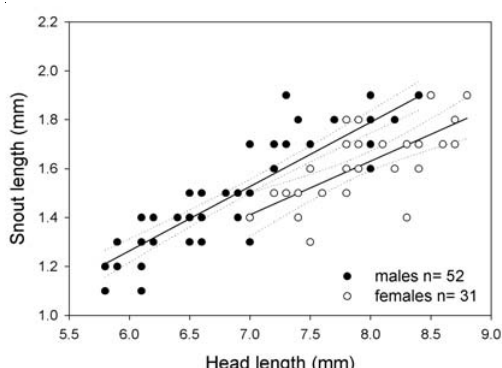
Fig. 10. Snout length as a function of head length for males against females of Odontostilbe pulchra